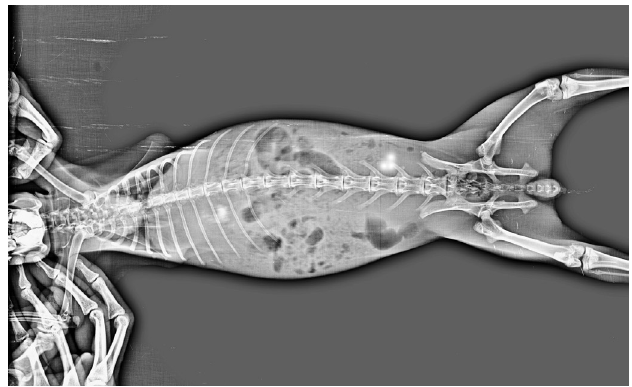
FIGURE 8 - X-ray image of formulation containing Guar Gum with barium sulphate after eight hour.